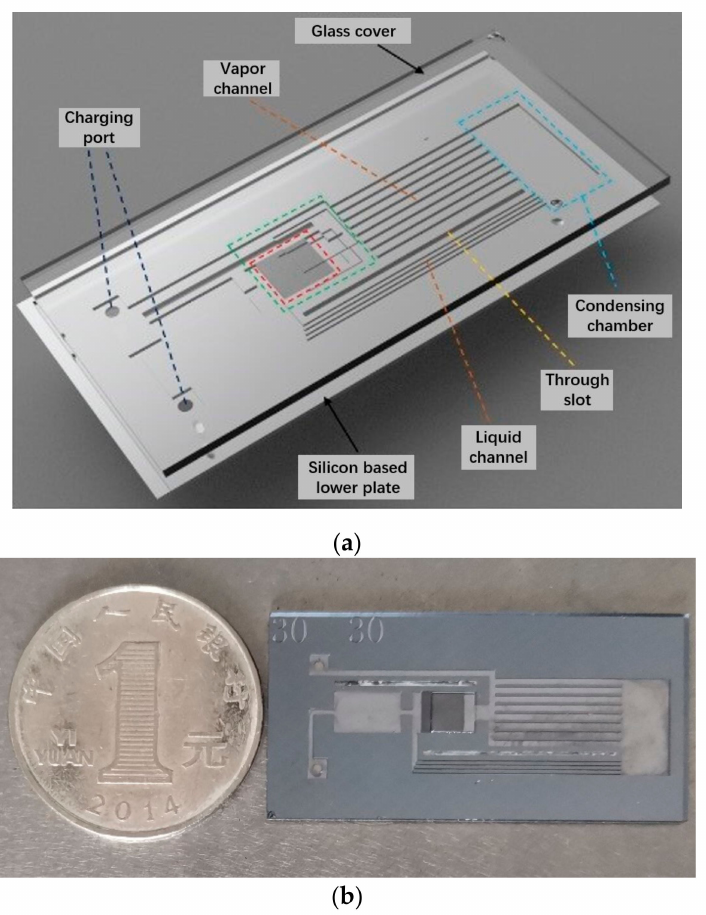
Figure 1. s-UTLHP prototype designed in this paper. ( a ) SolidWorks assembly sketch of s-UTLHP; ( b ) Physical drawing of